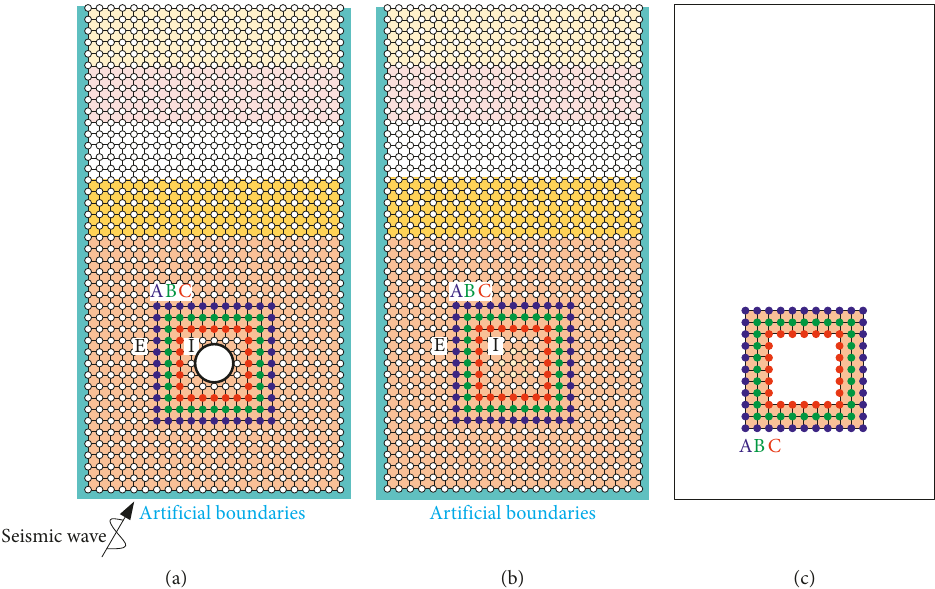
Figure 1: Finite element models of the (a) soil-structure system, (b) corresponding free field, and (c) internal